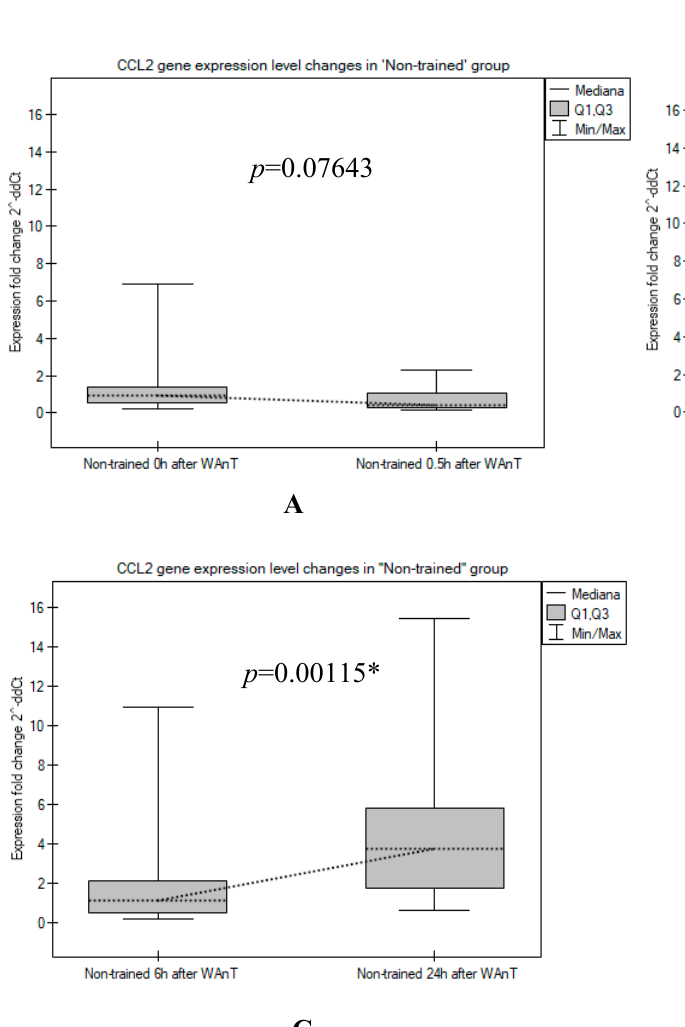
Figure 3. A comparison between the CCL2 gene expression levels measured in the “Non-trained” group in post-tests: ( A ) 0 h vs. 0.5 h after WAnT; ( B ) 0.5 h vs. 6 h after WAnT; and ( C ) 6 h vs. 24 h after WAnT ( p values are Mann–Whitney U-test asymptotic p values corrected for ties, * statistically significant differences).